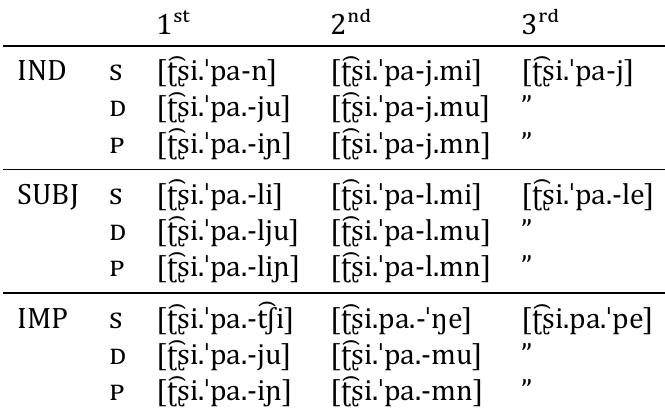
Table 7: Verbal paradigm for vowel-(cid:976)inal root [ʈ͡ʂipa-] ‘exit’, after Valdivia (1606).